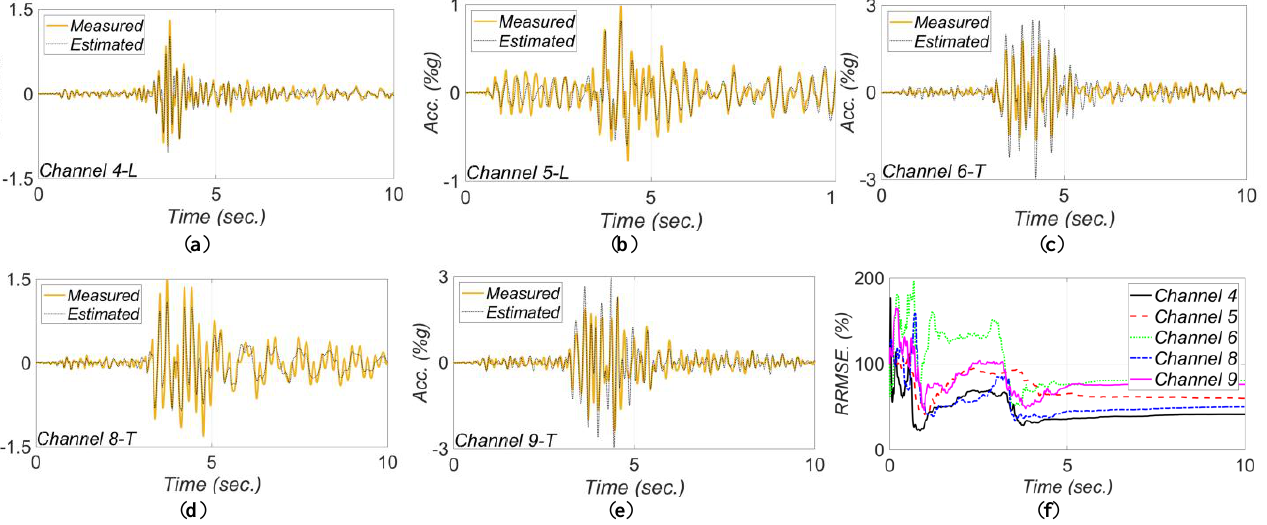
Figure 21. Comparison between measured and estimated (from updated model) responses at different measurement channels for 2018 Santa Cruz earthquake: ( a ) channel 4, ( b ) channel 5, ( c ) channel 6, ( d ) channel 8, ( e ) channel 9. Part ( f ) is the corresponding RRMSEs. 5. Digital Twin and Virtual Sensing Application The updated FE model is a replicate of the SRC bridge in the digital world given the training data, and is referred to as its digital twin (DT). The DT can be used to reconstruct local element- and material-level responses to diagnose damage at local levels of the bridge. For this purpose, the DT is used in a forward simulation for a given input motion and the local responses (e.g., section moment curvature, material stress-strain) are col- lected and used for damage localization and quantification. The process is often referred to as virtual sensing [45]. Although the level of available earthquake motions was small in this study and thus, no damage is expected in the structure, the application of the DT can still be demonstrated. It should be noted that the phrase “Digital Twin” may have different meanings and applications in different industries. Here, the digital twinning method is used for post-earthquake assessment of bridges. The data recorded in seismic events are considered as discontinuous real-time data assuming that no significant changes will happen between the events. Therefore, the DT will be updated after each seismic event and used for post-earthquake damage diagnosis. In this section, the SRC DT is established using the final estimates of the unknown model parameters from the 2013 IslaVista earthquake data (earthquake No. 3). Then, the estimated FIMs are used with the DT to monitor/estimate the structural responses. Figure 22 shows two examples of such monitored/estimated responses at local levels. Figure 22a presents the estimated moment- curvature response at the lowest section of the east pier about the transverse direction.